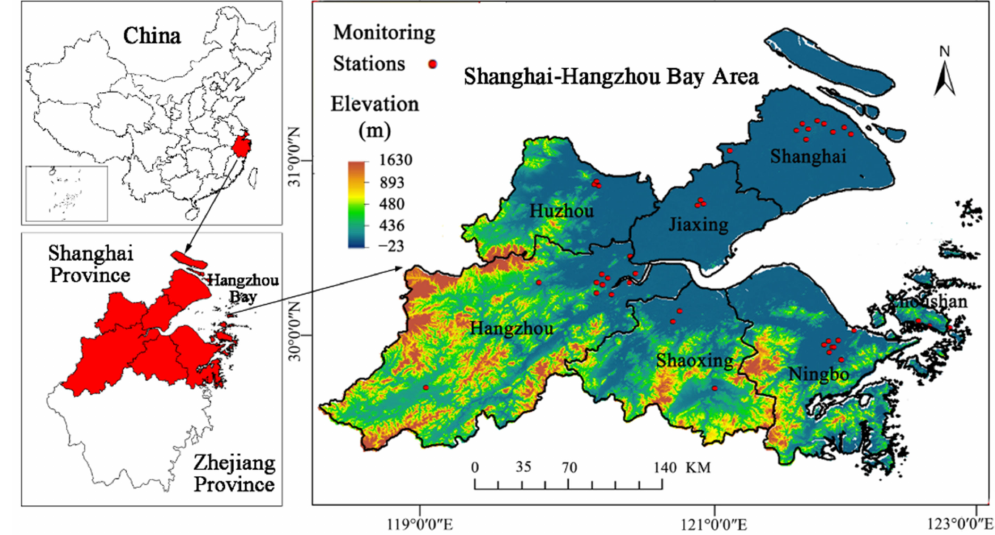
Figure 1. The location and elevation map of the study area,